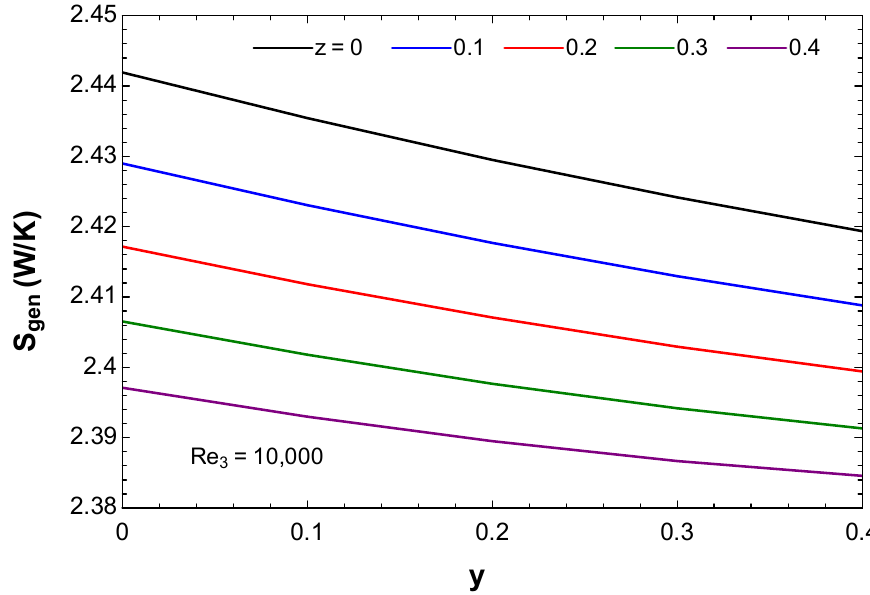
Figure 8. Effect of airflow ratios on entropy generation. The impacts of the Reynolds number in the third pass ( Re 3 ) and the airflow ratios are sure loss increased. The convection heat transfer coefficient was proportional to the 0.8 power of the Reynolds number (Equation (14)) and the air pumping power was